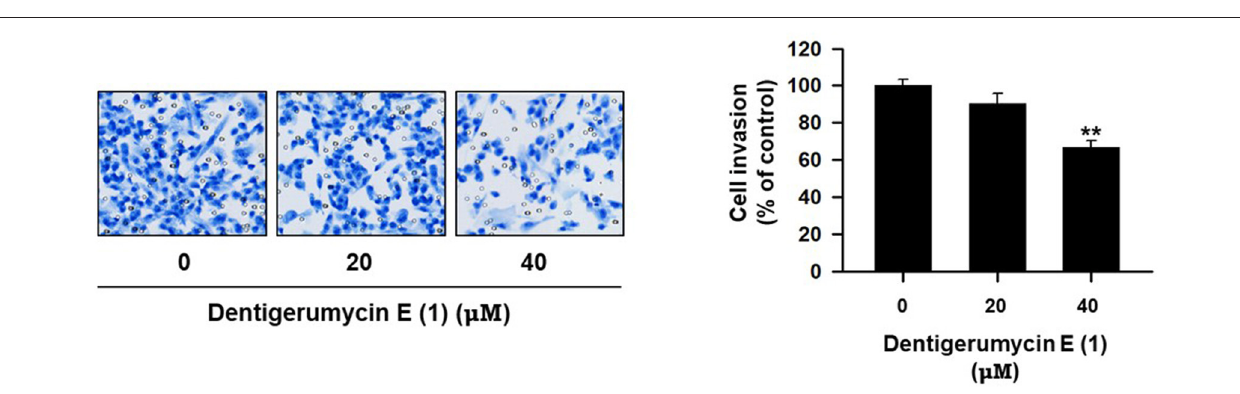
6606, 6605, and 6604) showed high degree similarity to that of dentigerumycins B-D (Wyche et al., 2017). Based on the antiSMASH analysis, these modules produce a cyclic peptide with the sequence Leu-Pip-3-Gly-Pip-2-Pip-1-Thr, which is